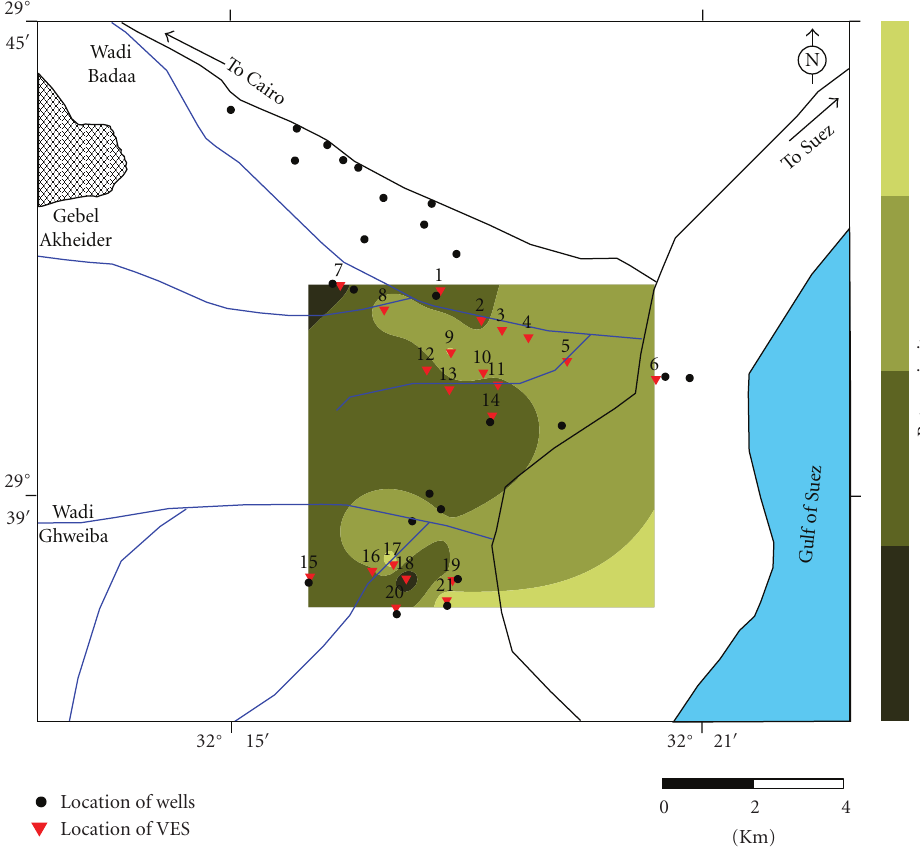
Figure 16: Priority map for drilling water wells in the study